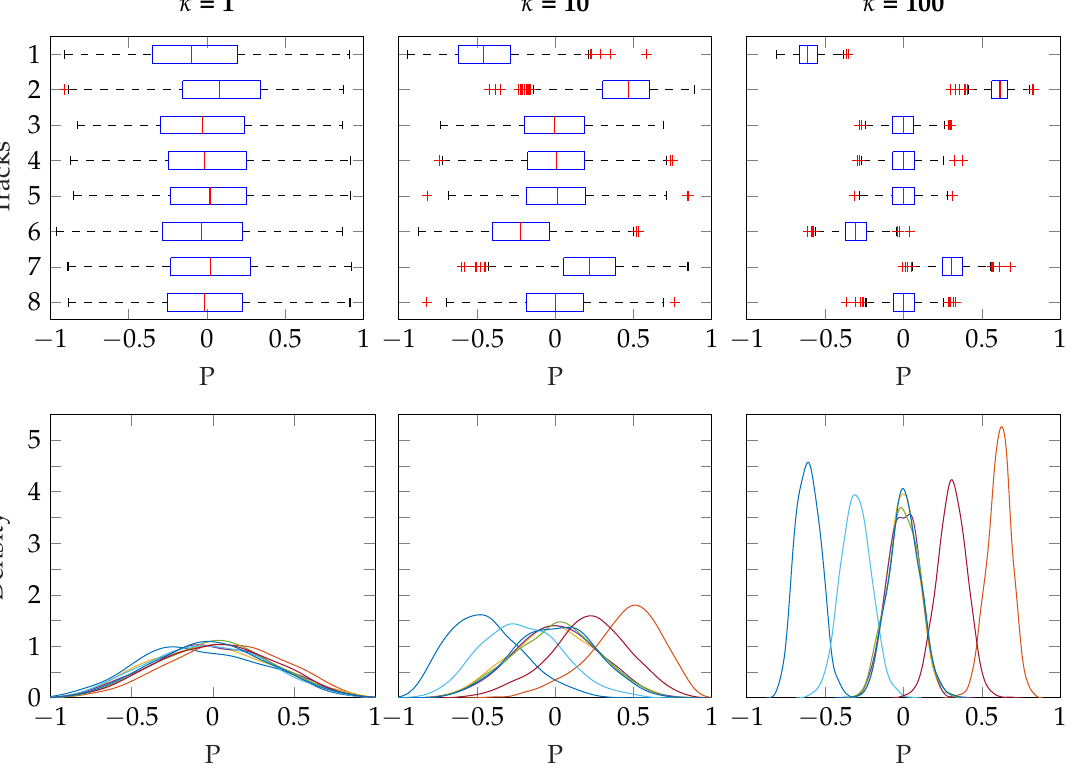
Figure 10. Panning method 2—generating vMF distributions in panning space. As expected, increasing κ (concentration parameter) results in a narrower range of pan positions for each track, around the target vector Equation (13).